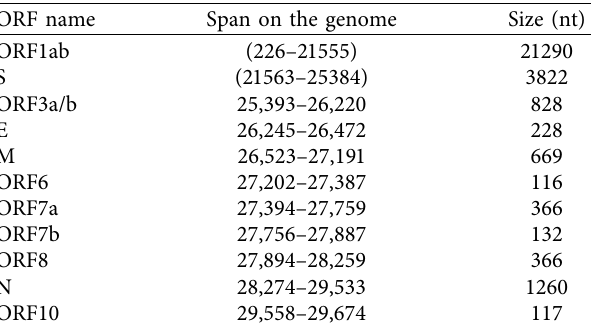
Table 1: Size and span of the ORFs in SARS-CoV-2 according to the NCBI reference genome